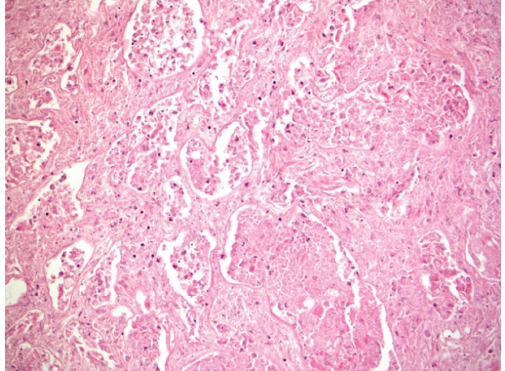
Figure 2: Coagulative necrosis in the central part of the tumour. Figure 3: Irregular nests of viable neoplastic